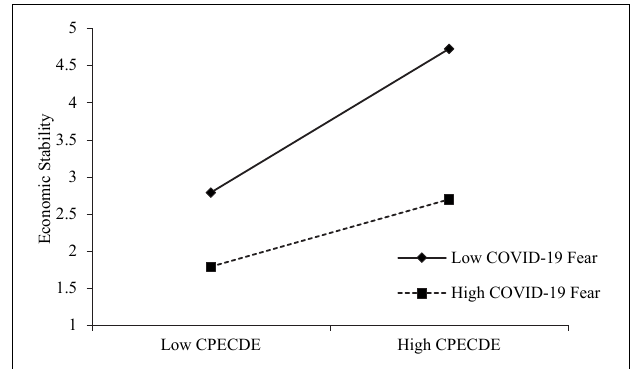
FIGURE 2 | Moderating effect of COVID-19 Fear in the relationship between CPEC development and economic stability. CPECDE, CPEC